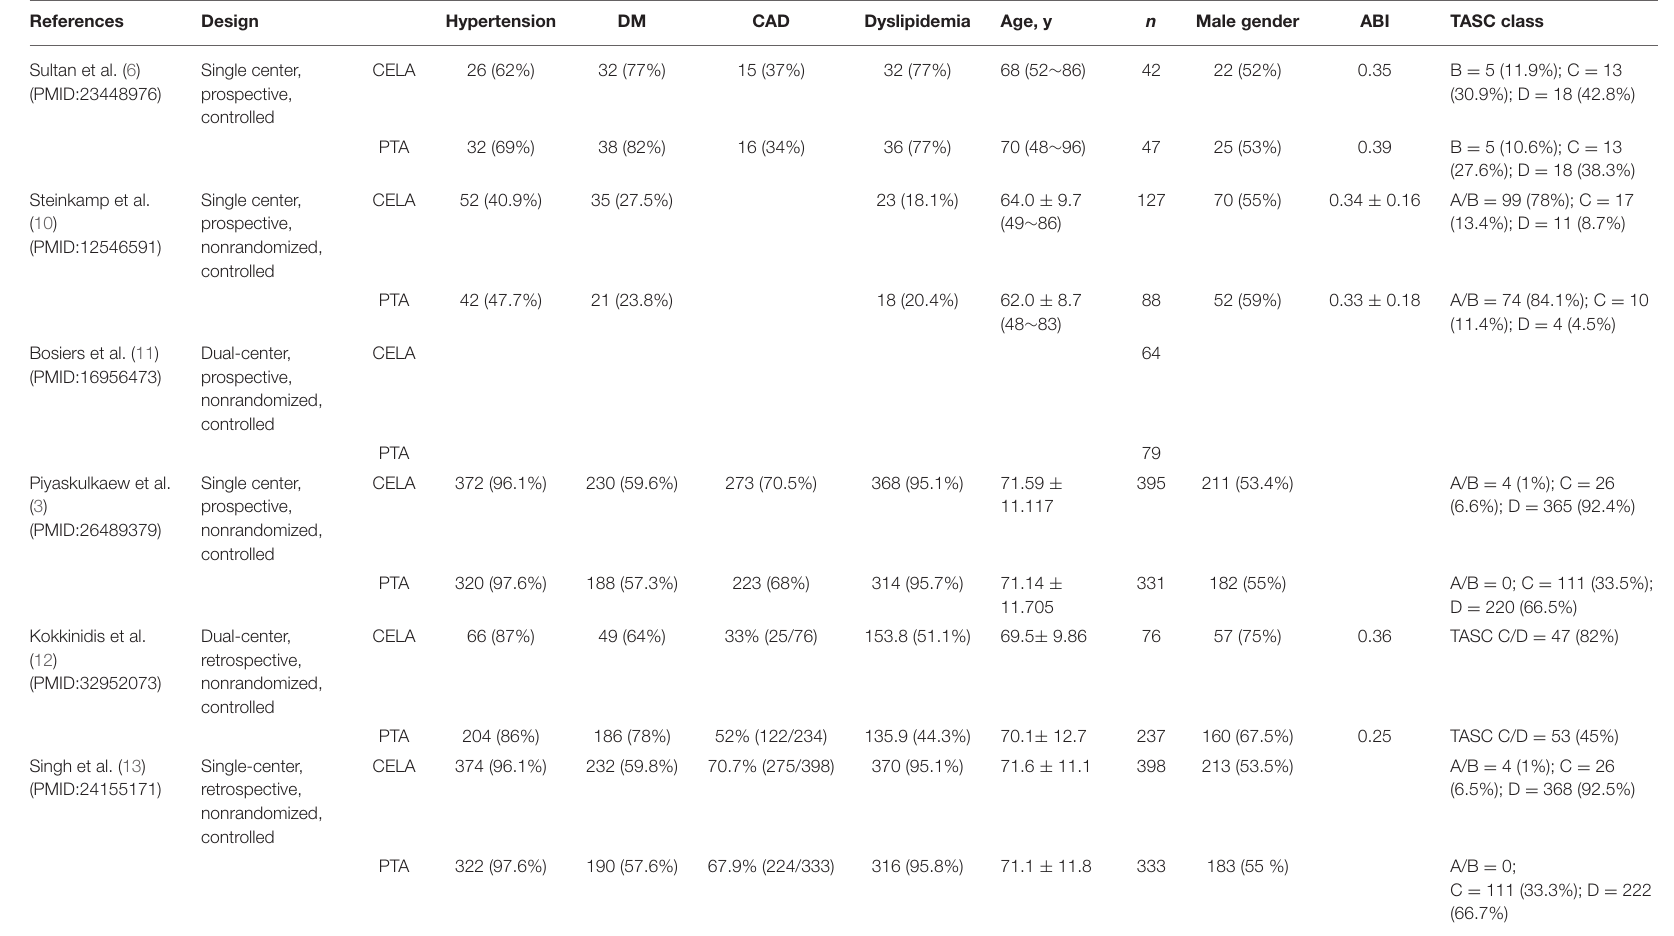
TABLE 1 | Characteristics of included